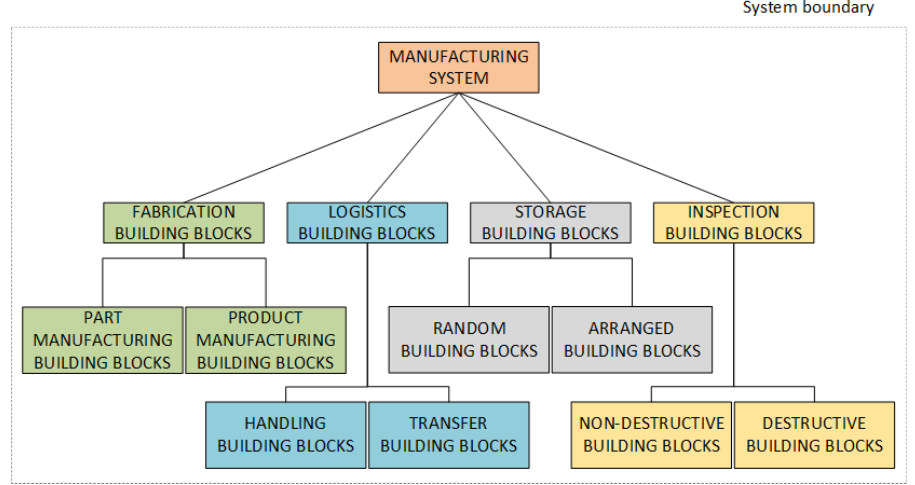
Figure 3. The manufacturing system broken down into four groups of building blocks.